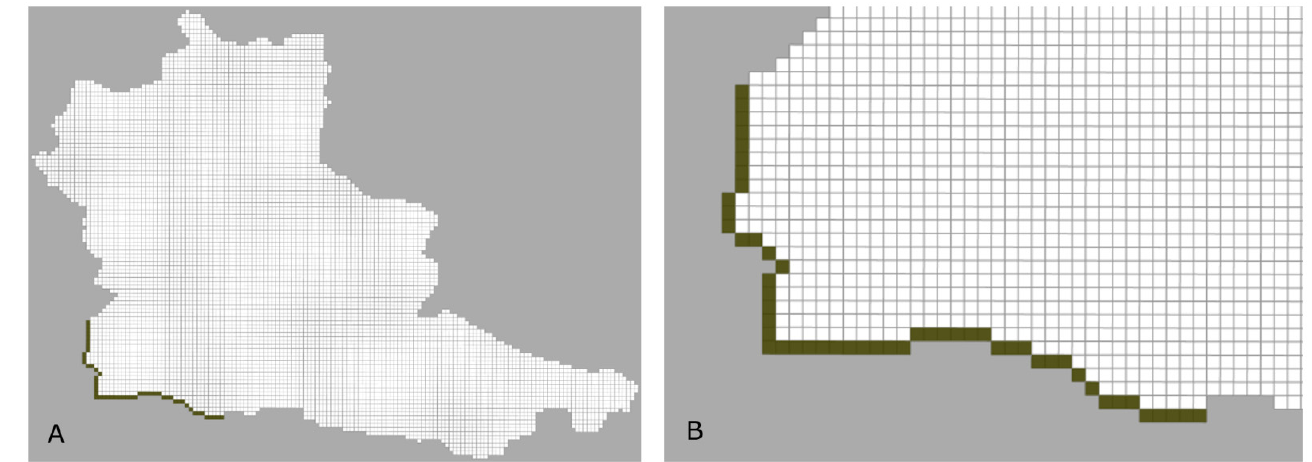
Figure 9. Location of the General-Head Boundary (dirty green cells) within the 3rd, 4th, 5th and 6th layer: whole model ( A ) and SW part of the model ( B ).